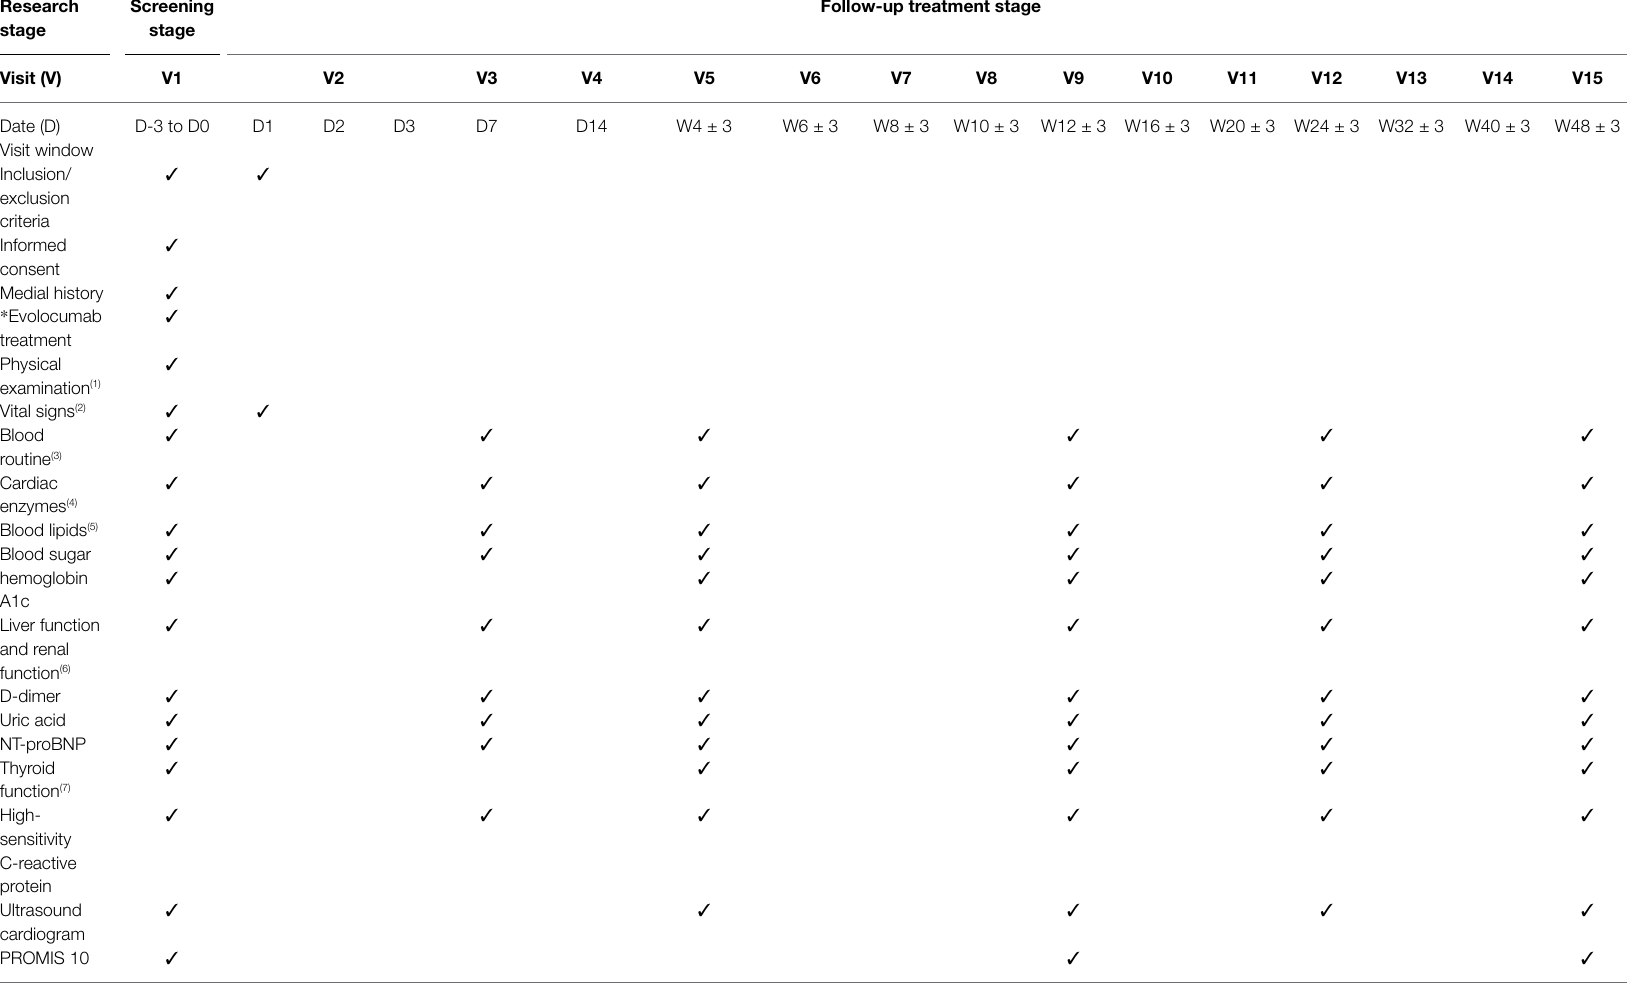
TABLE 1 | Schedule of treatments and assessments administered to patients. Research